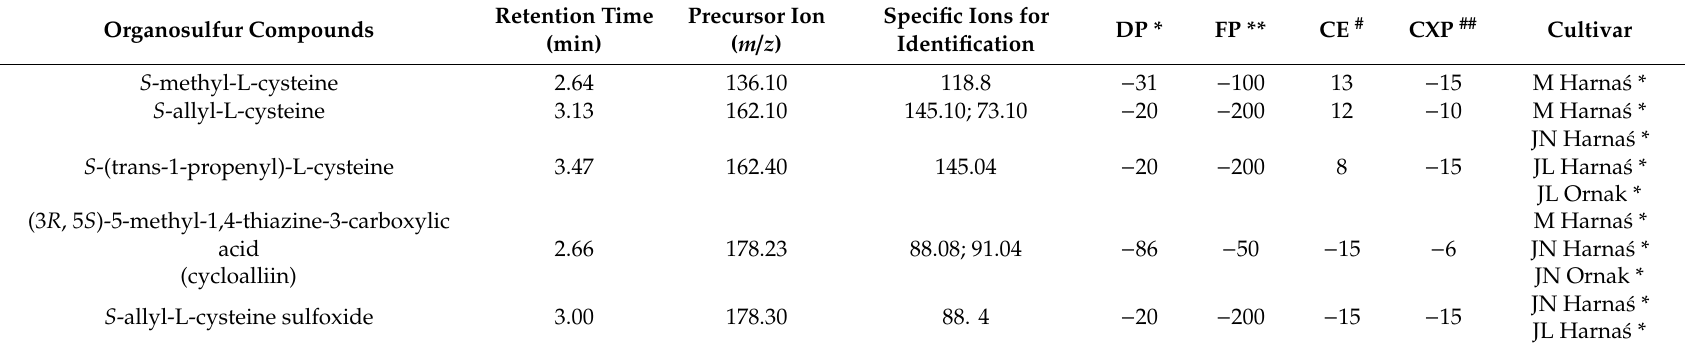
Table 4. Mass spectrometry parameters for organosulfur compounds identified in whole plants of garlic cultivated from air bulbils. Organosulfur